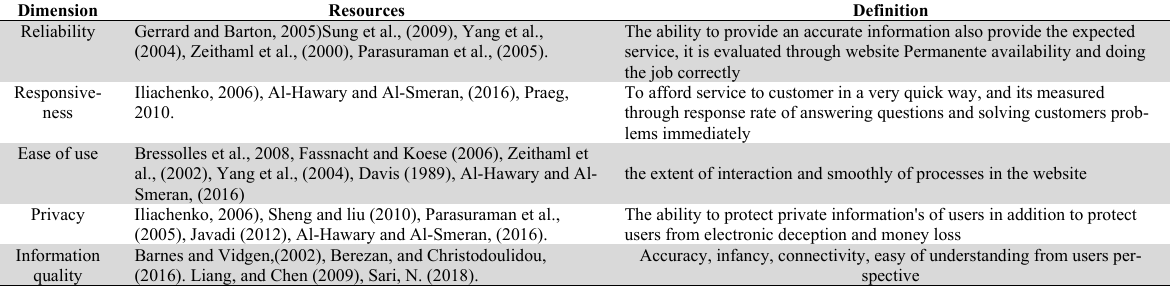
Dimensions of electronic service quality adopted in this study Dimension Resources Definition Reliability Gerrard and Barton, 2005 )Sung et al., (2009), Yang et al., (2004), Zeithaml et al., (2000), Parasuraman et al.,